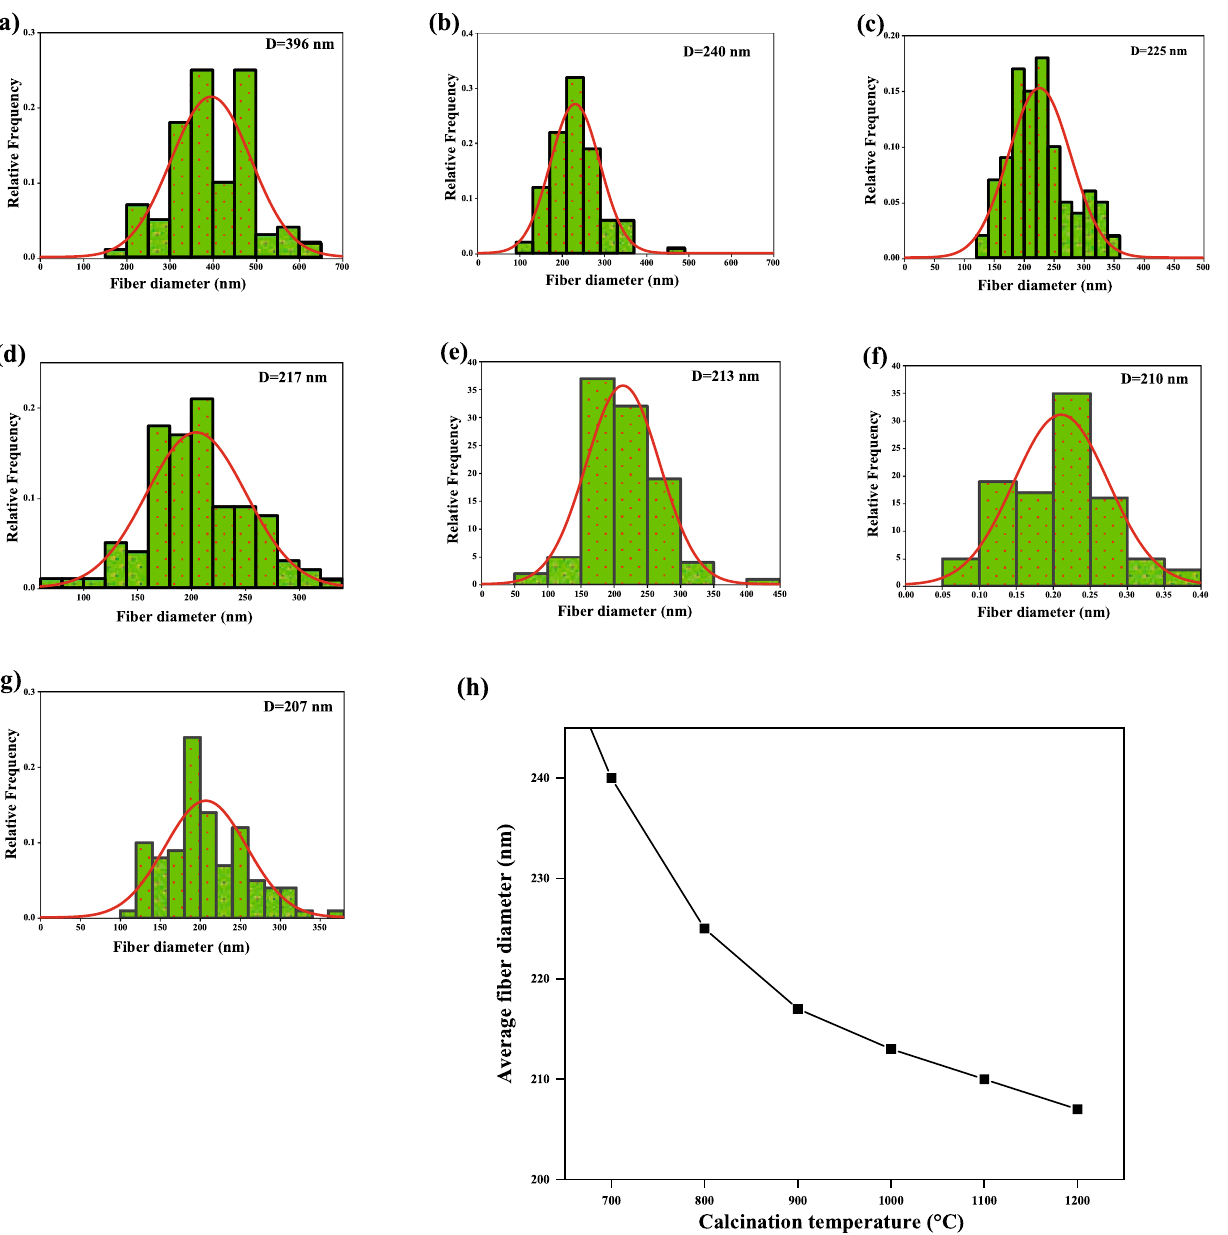
Fig. 7 Histograms of average fiber diameter ( a ) PVA/BeSO /PEI precursor nanofibers, heated at ( b ) 700 °C, ( c ) 800 °C, ( d ) 900 °C, ( e ) 1000 °C, 4 ( f ) 1100 °C, ( g ) 1200 °C and ( h ) effect of calcination temperatures on average fiber diameter of BeO